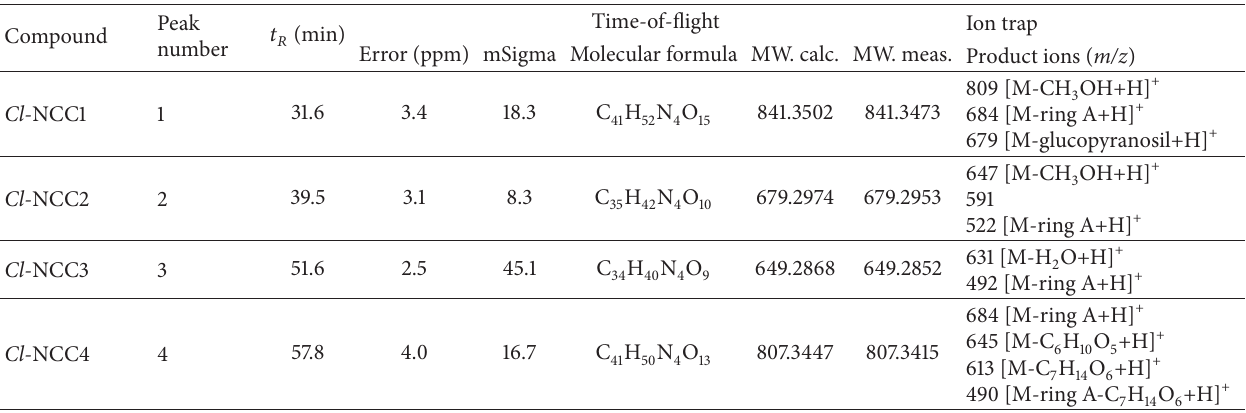
Table 2: Nonfluorescent chlorophyll catabolites composition in lemon fruit peels ( Citrus limon L.) determined by HPLC/ESI-IT/high resolution